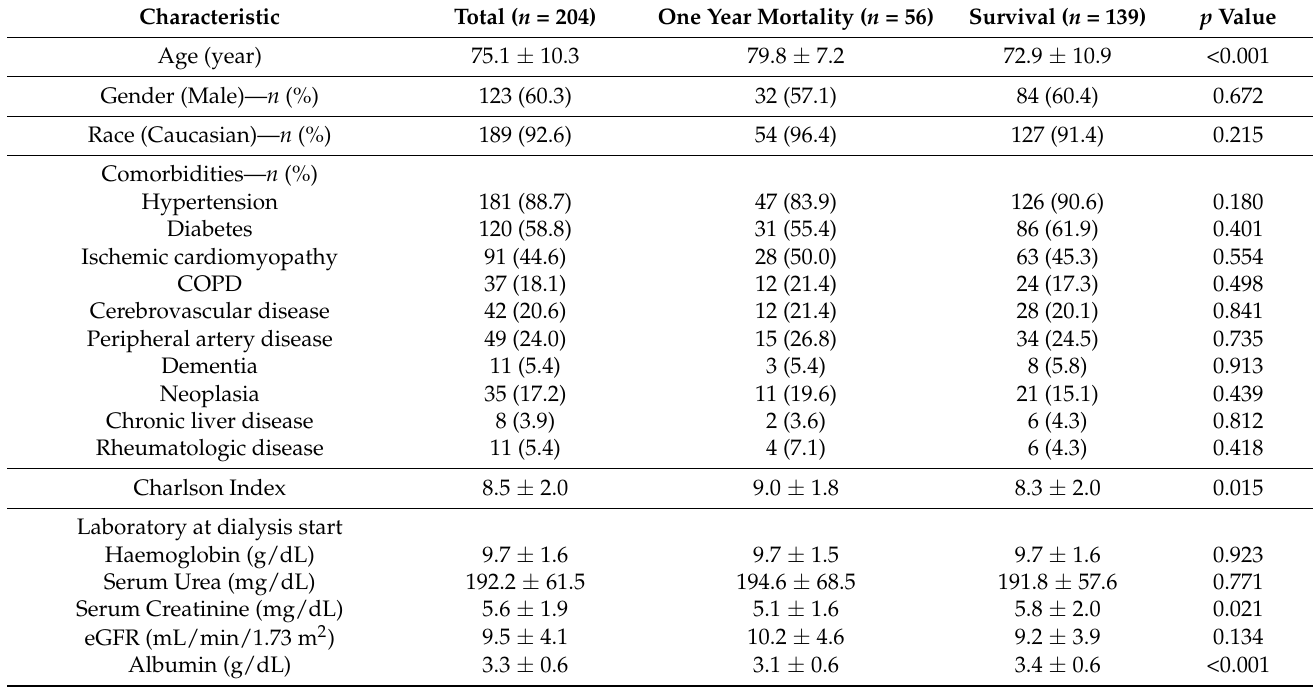
Table 1. Baseline